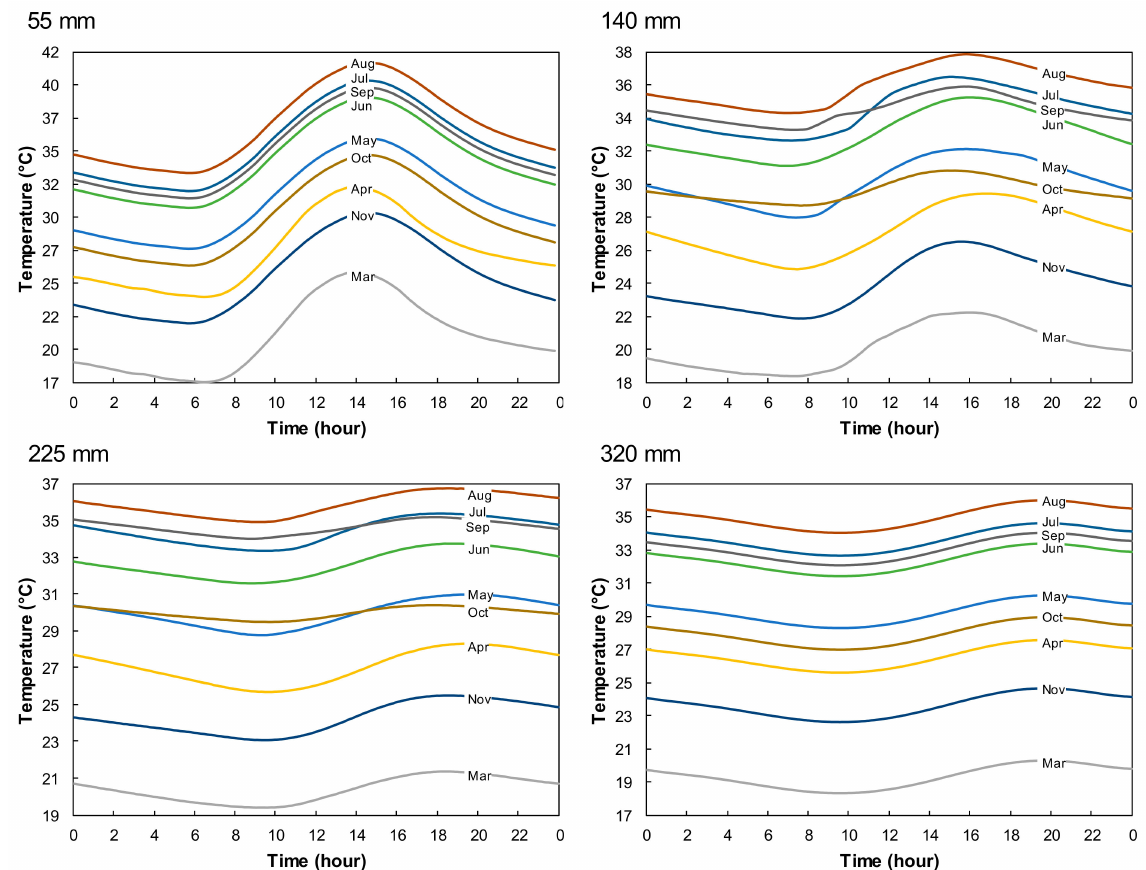
Figure 4. Soil temperature boundary conditions from March to November at depths of 55 mm (top surface), 140 mm, 225 mm, and 320 mm (bottom surface).